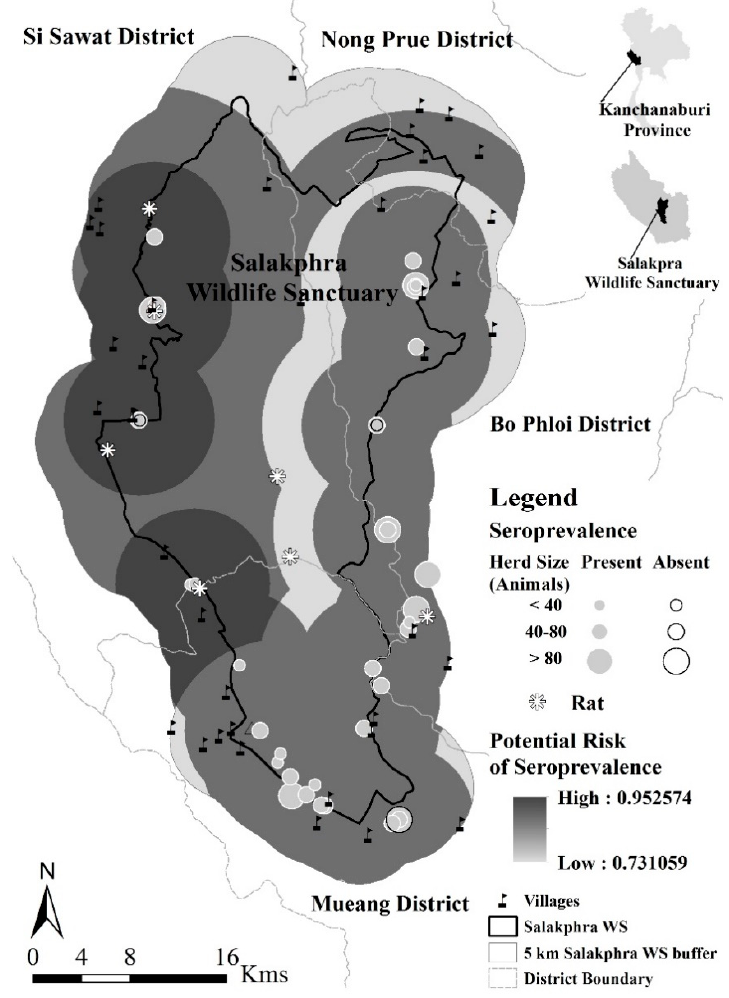
Figure 1. The location of cattle and the seroprevalence along the Salakphra Wildlife Sanctuary.